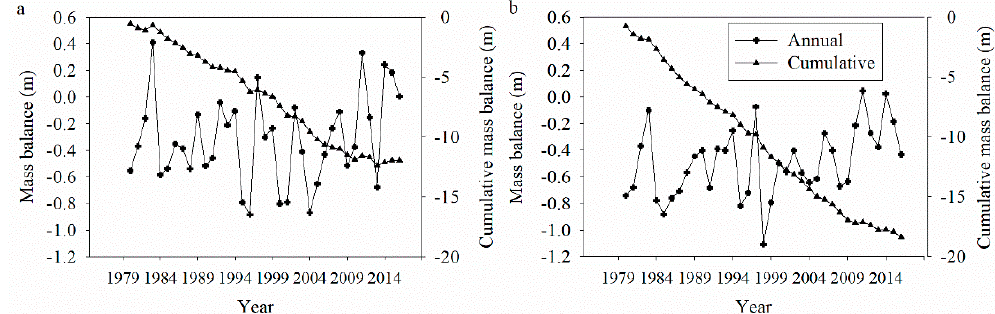
Figure 6. Mean annual GMB and cumulative GMB in the Toxkan and Kumalak River catchments during 1979–2015. ( a ) Toxkan River catchment; ( b ) Kumalak River catchment.